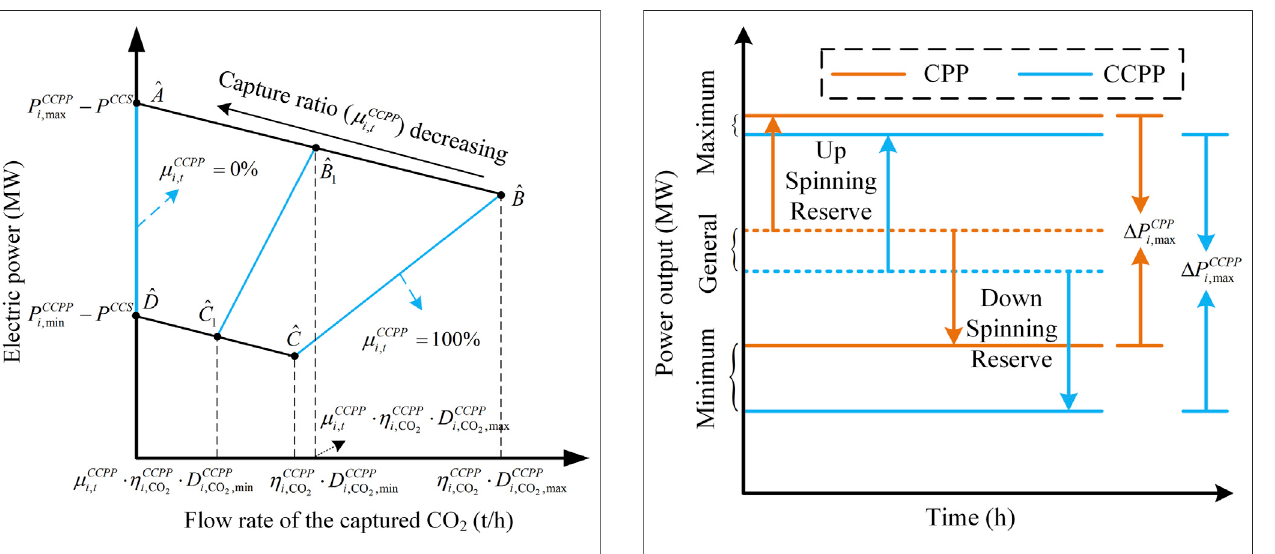
FIGURE 4 | Maximum regulation capacities of CPP and CCPP. FIGURE 2 | Power-carbon characteristic of the CCPP